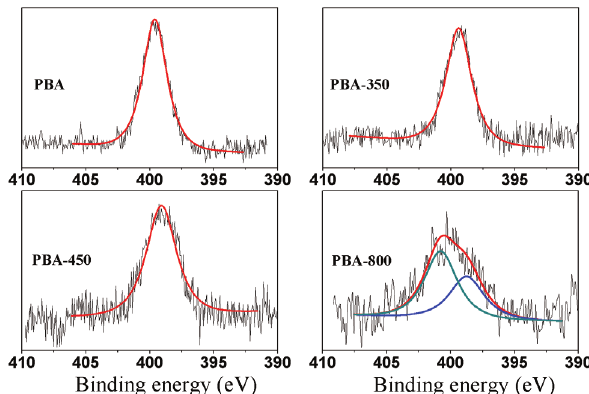
Fig. 4: N 1s XPS spectra of PBA and its chars obtained at various